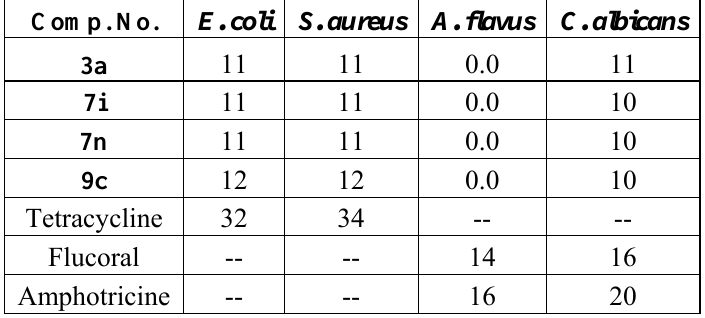
Table 1 . Antimicrobial screening results of the tested